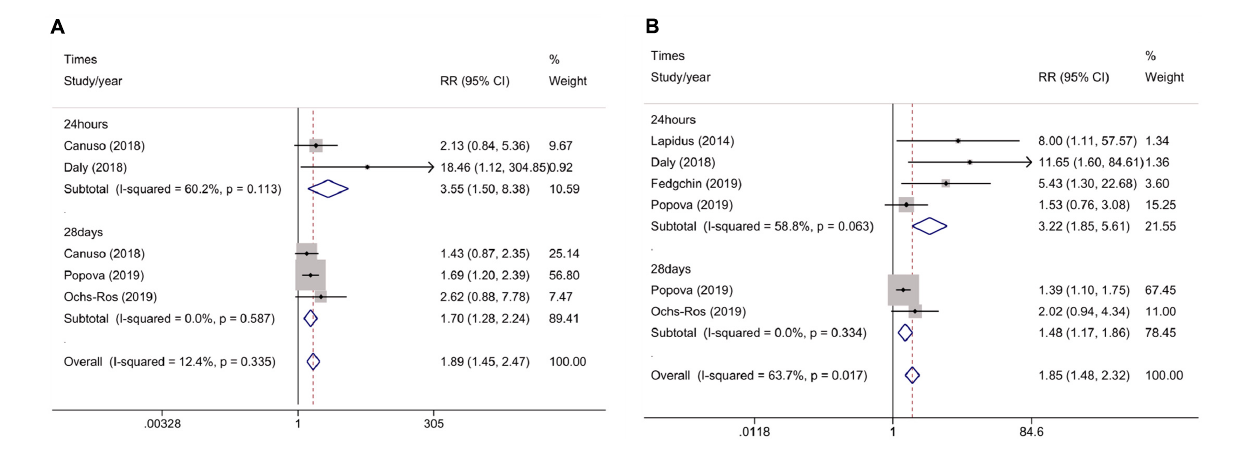
Daly 2018 (28 mg) was excluded, and 6.41 (95% CI, 4.50 to 8.31, and P = 0.00) when study Canuso 2018 was excluded ( Table 2